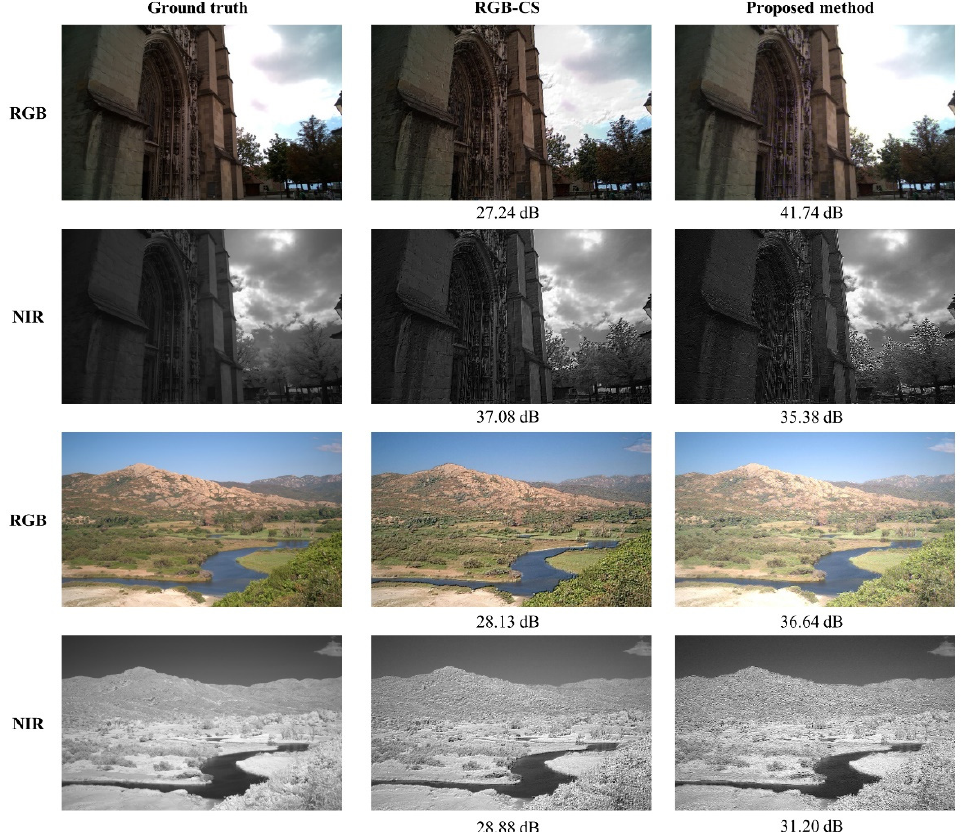
Figure 12. The subjective quality comparison between RGB-CS [21] and the proposed method (Note: the result images were encoded by portable network graphics (PNG) format).